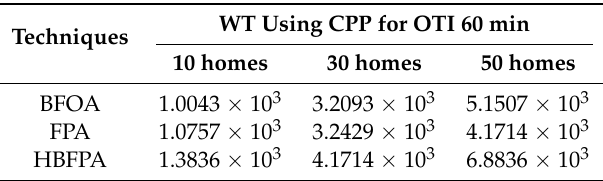
Table 19. Waiting time for 24 h (for multiple